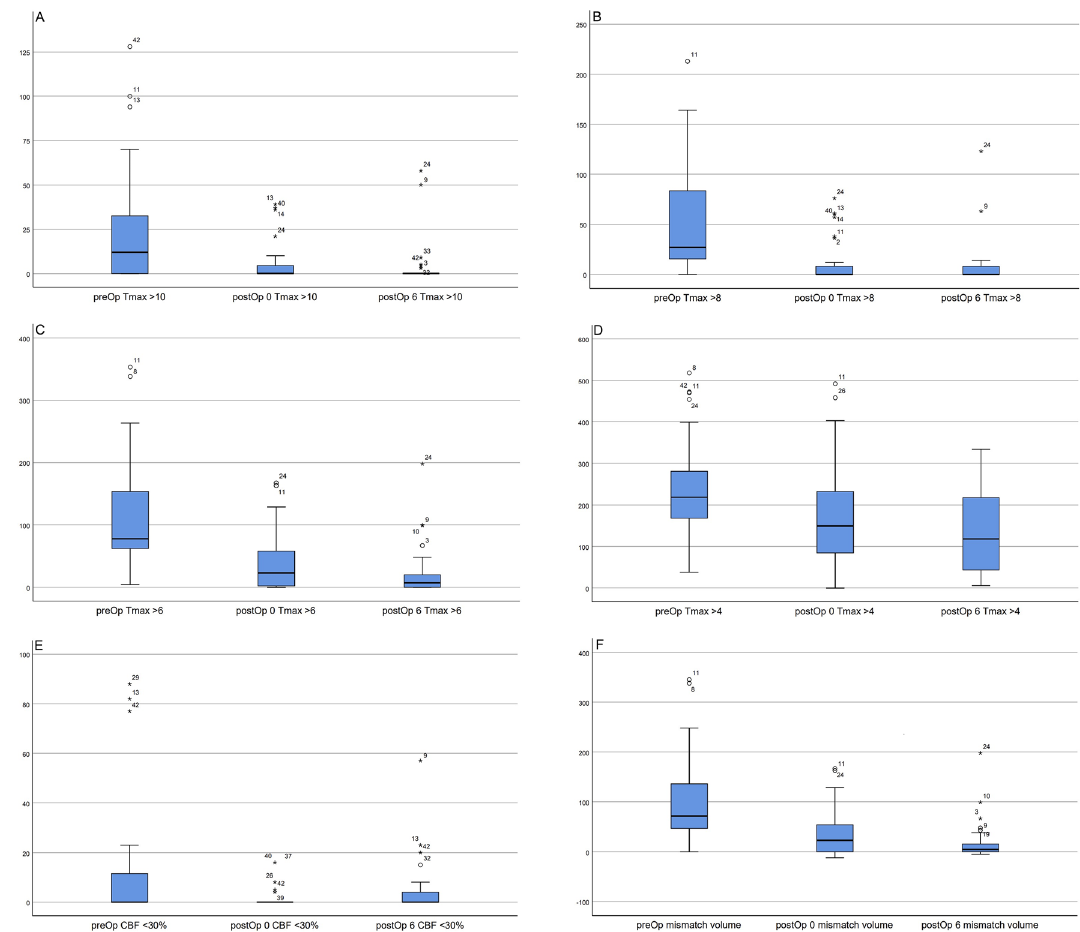
Figure 2. ( A ) The value of Tmax > 10 s of pre-, immediate postoperative, and 6 months postoperative presented a continuous decrease as follows: preoperative, 12 mL (0–34); immediate post-operative, 0 mL (0–6);